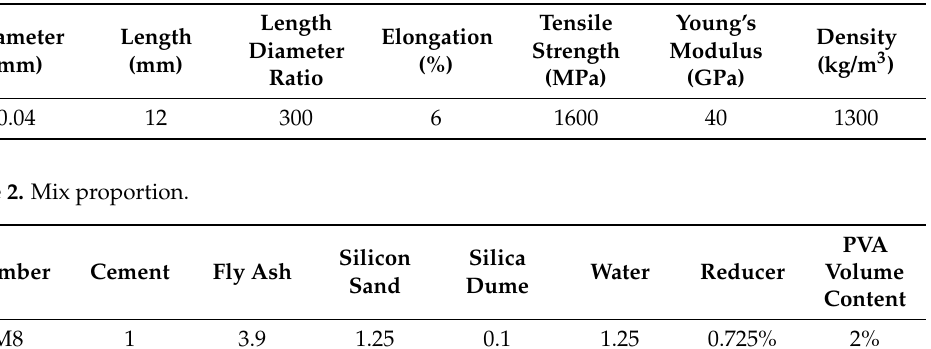
Table 1. Polyvinyl alcohol (PVA) fiber parameters.